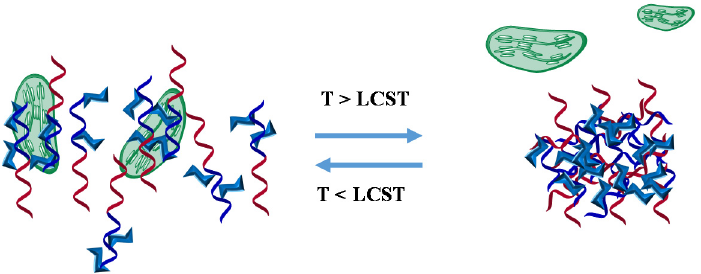
Figure 4. Representation of interaction between block thermoreversible glycopolymers and bacteria in water